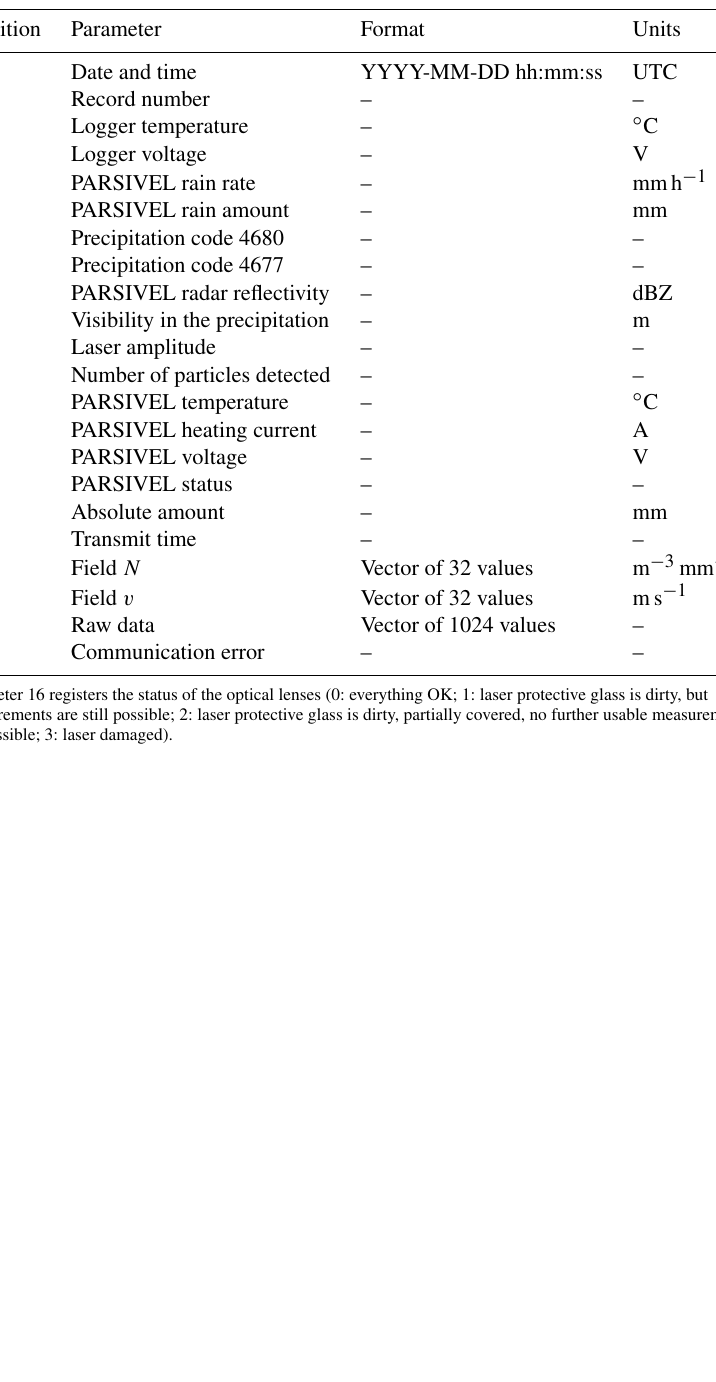
Table C1. PARSIVEL raw data